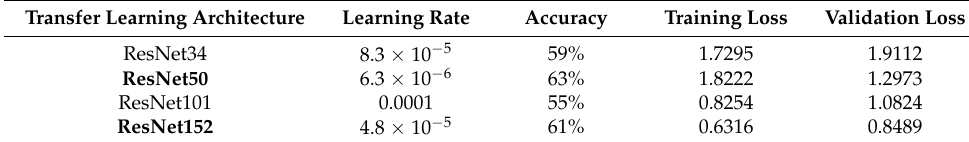
Table 1. Results of RetinaNet models trained using samples collected from depression analysis.